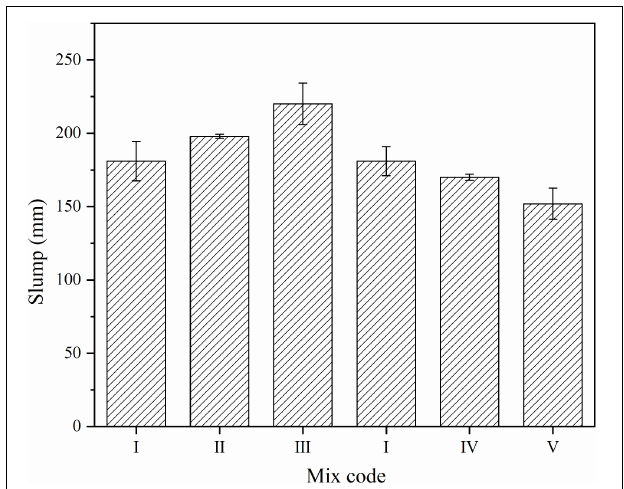
FIGURE 1 | Flowability of